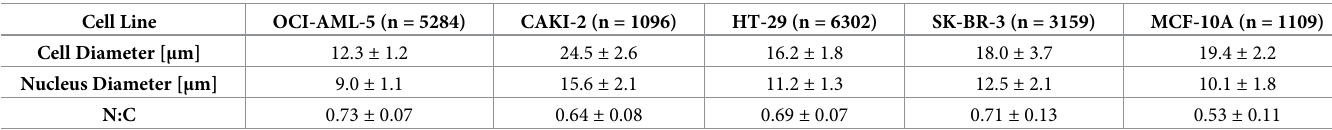
Table 1. A summary of IFC measurements and corresponding standard deviations for the cell and nucleus diameter as well as the N:C ratio for each cell line. Cell